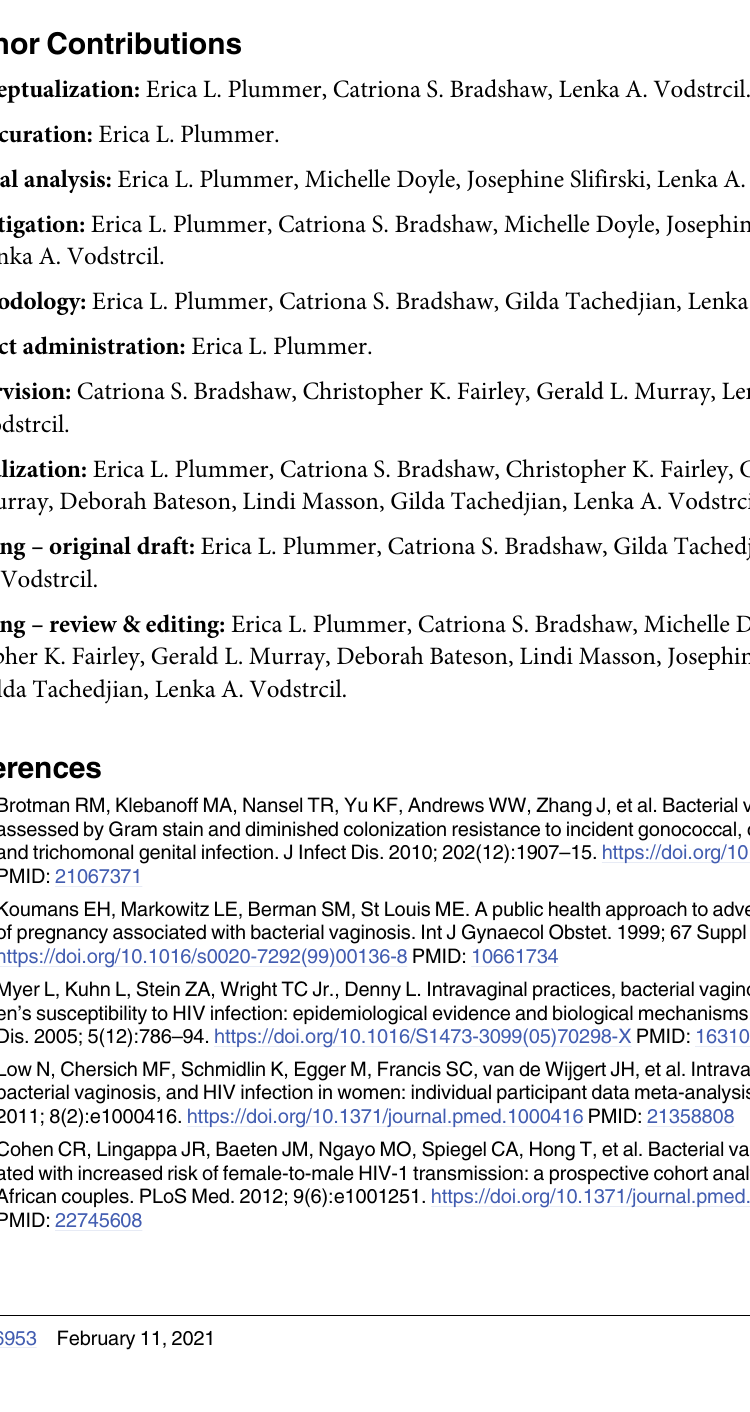
S2 Table. Bias assessment tool. S3 Table. Full text articles excluded and reasons for exclusion. S4 Table. Adverse events reported in included